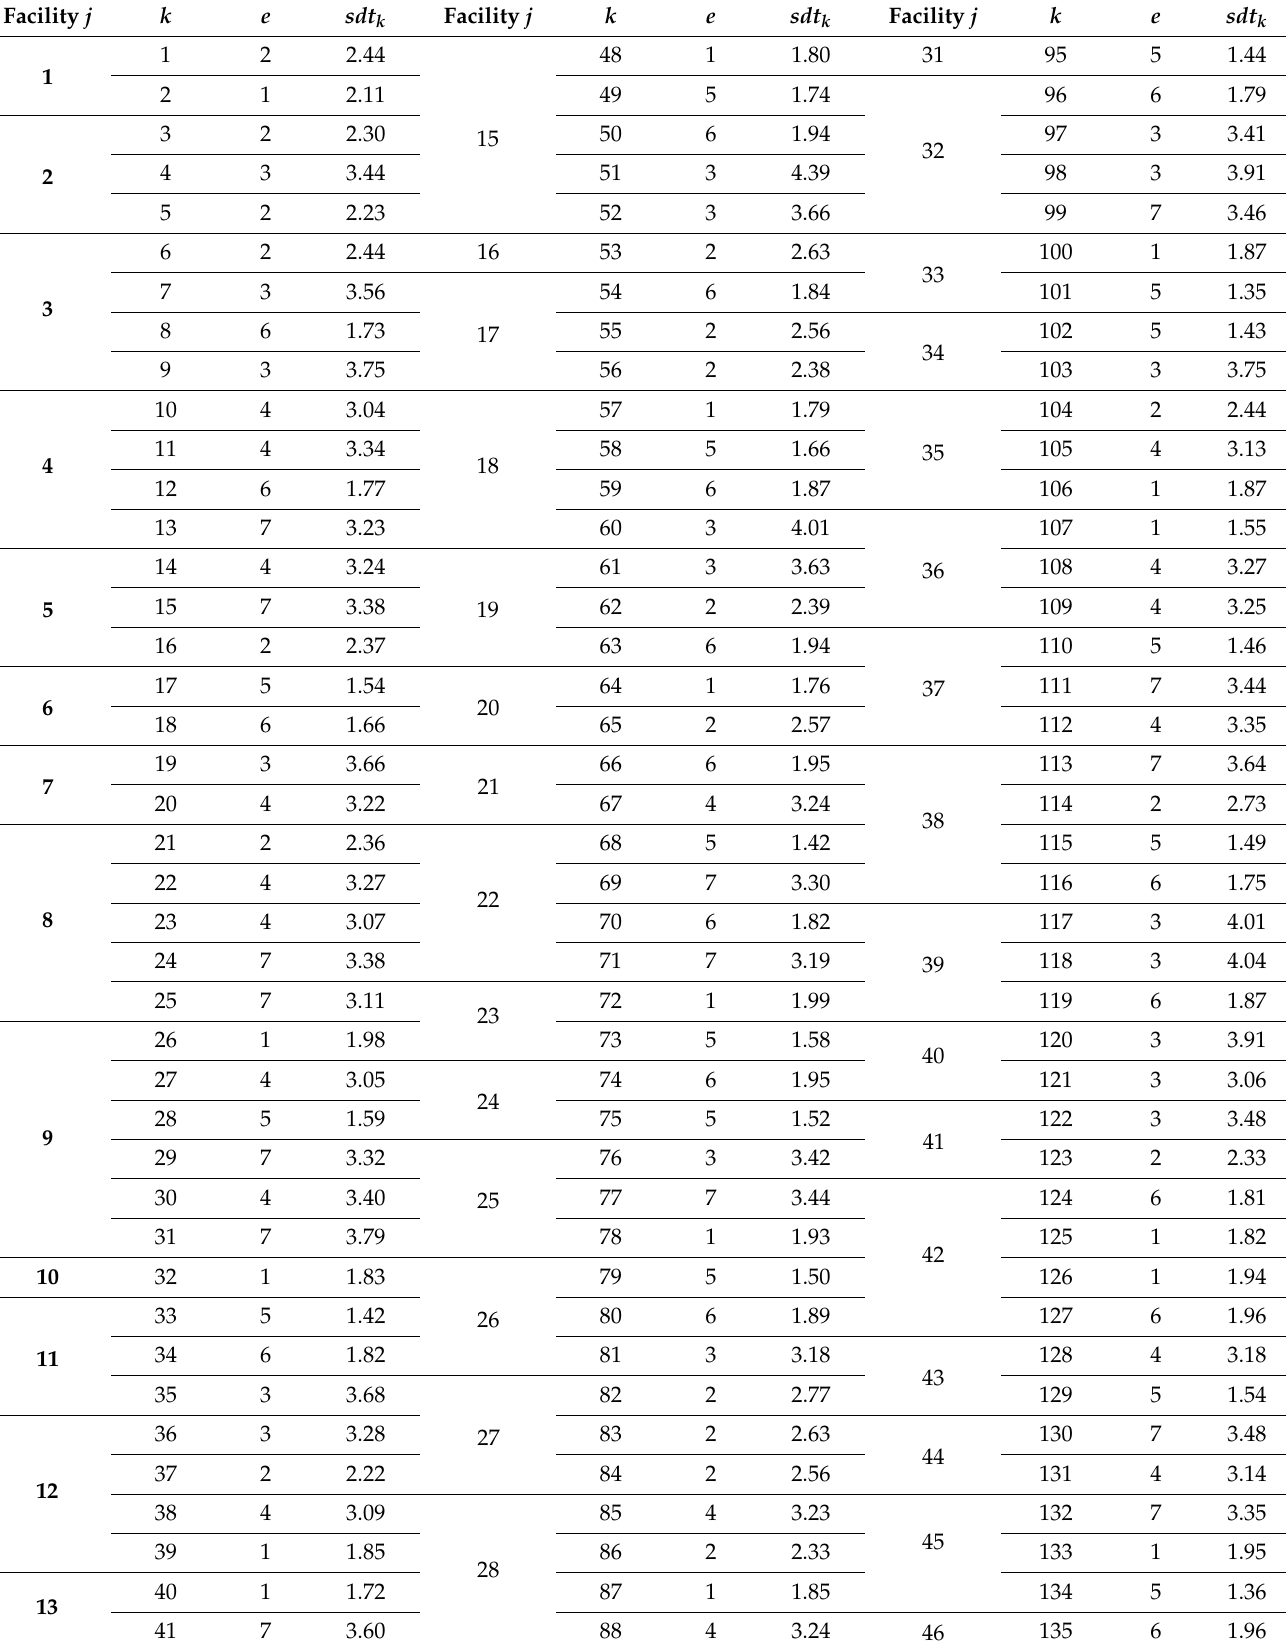
Table 5. The generated standard durations and types for each